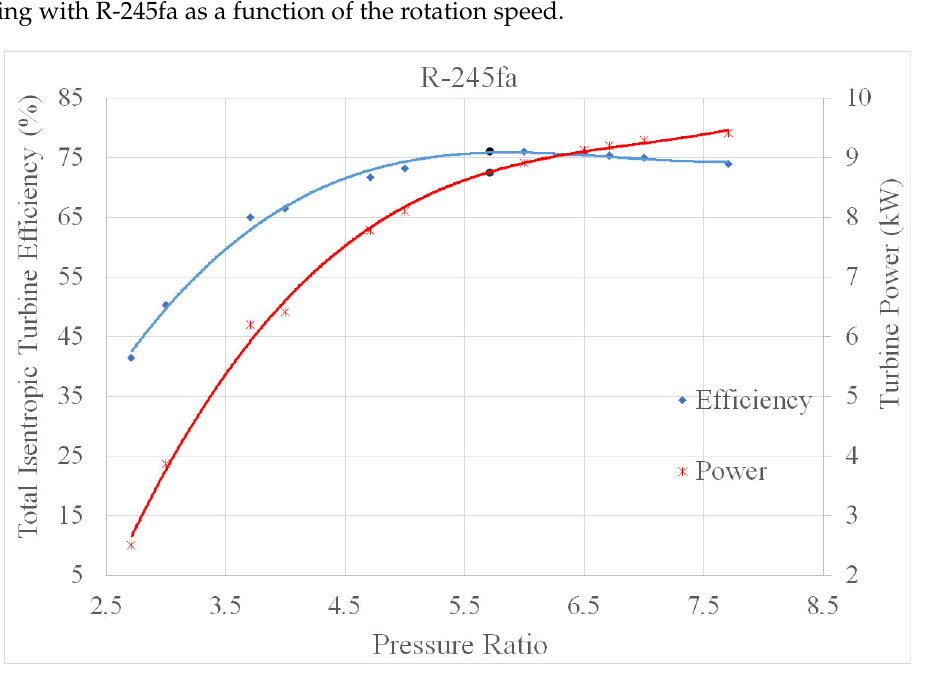
Figure 13. Variation in the total isentropic efficiency and power of the turbine operating with R-245fa, as a function of pressure ratio.